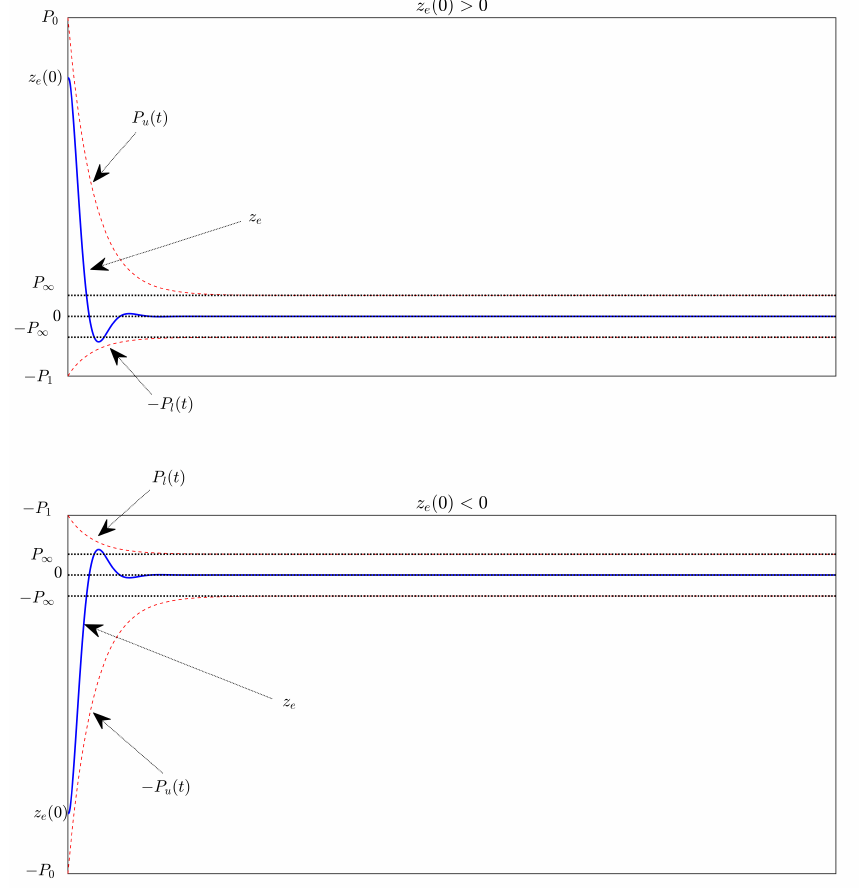
Figure 1. Description of the prescribed performance